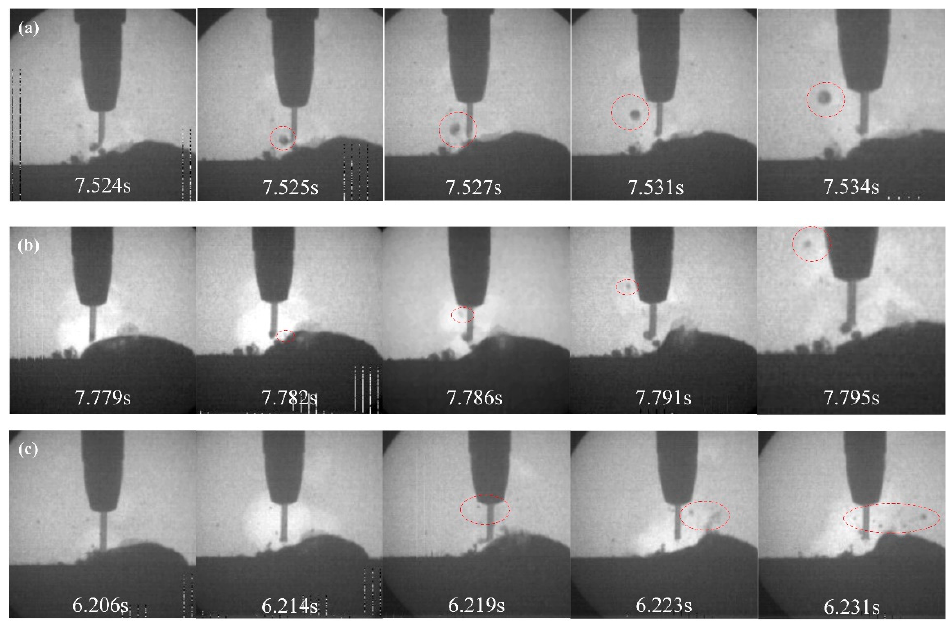
Figure 10. Spatters during metal transfer process at 15% filling rate. ( a ) Droplet repelled spatter. ( b ) Weld pool oscillation spatter. ( c ) Explosive spatter.